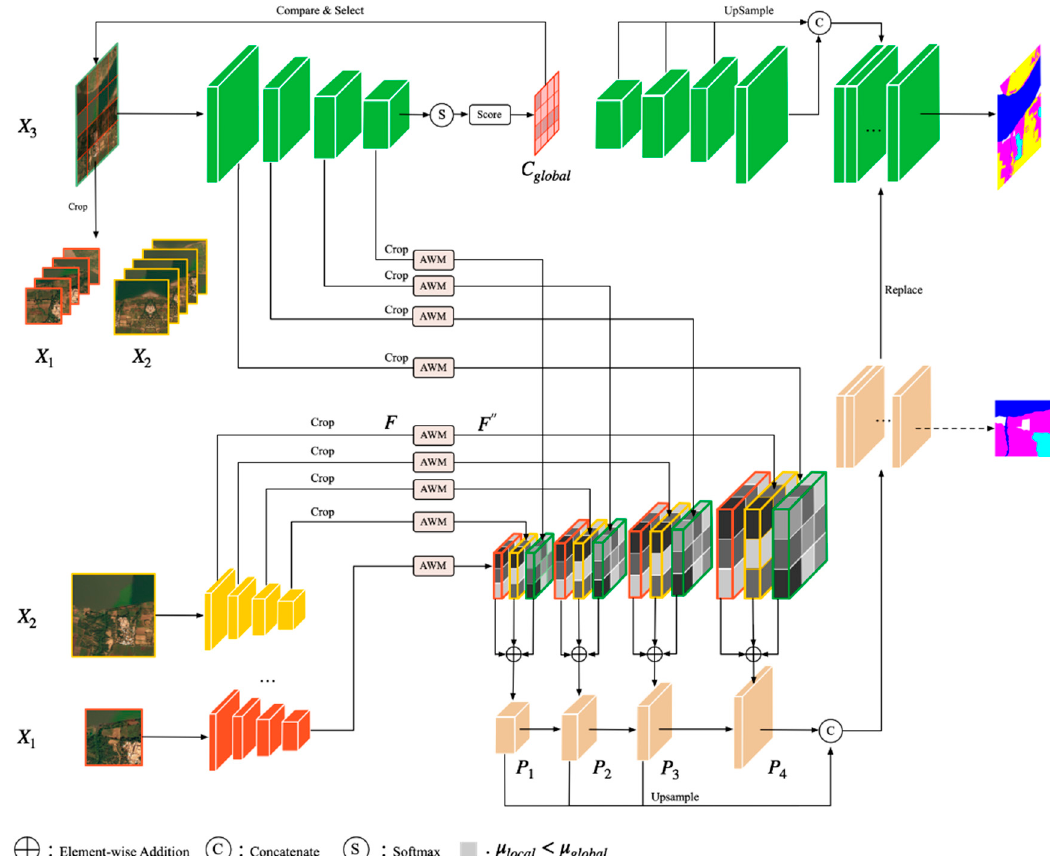
Figure 5. Interaction of PSM and FM.